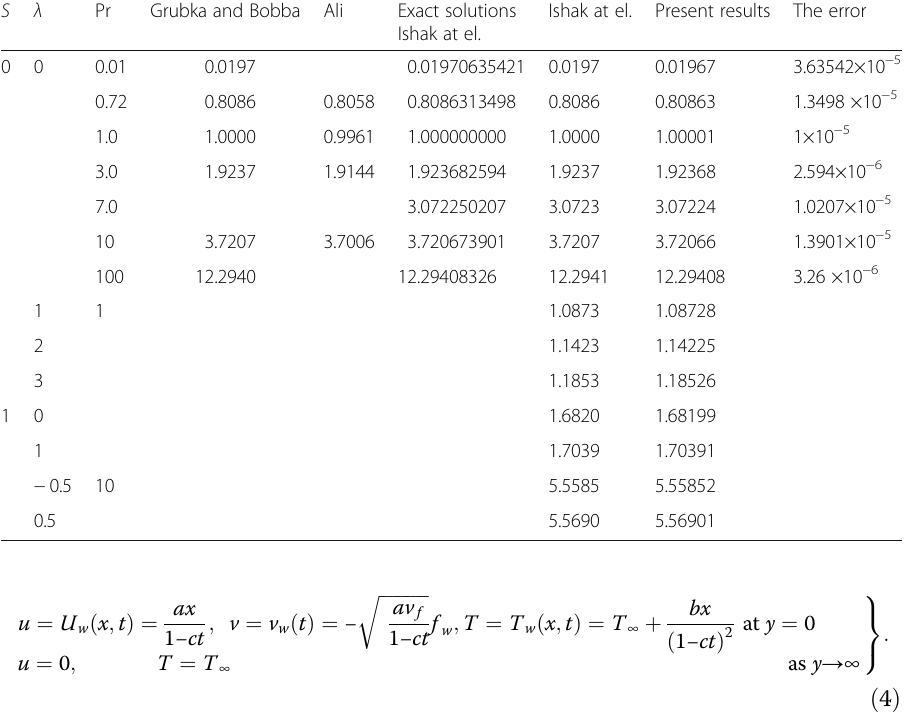
Table 2 Values of − θ ′ (0) for various values of S , λ , and Pr (the error = exact solutions − present results) Pr Grubka and Bobba Ali Exact solutions Ishak at el. Present results The Ishak at el.